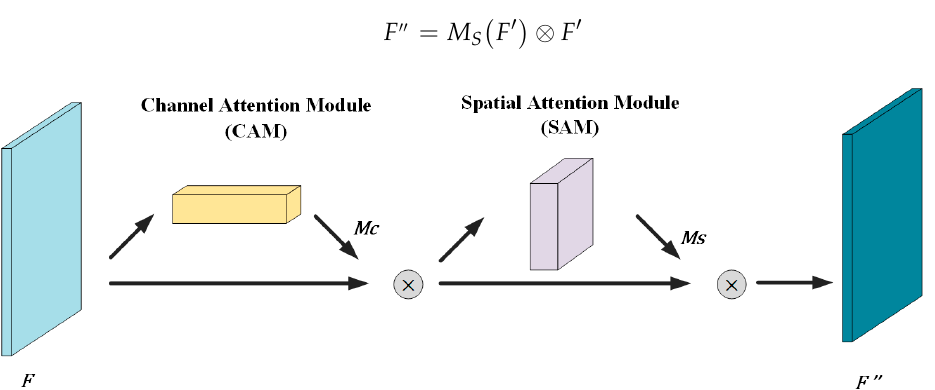
Figure 3. CBAM block